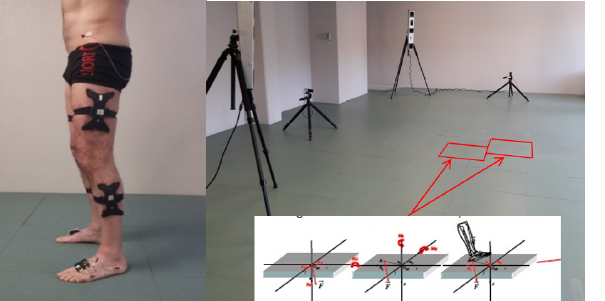
Figure 2. Clinical gait analysis. Different types of sensors are used to conduct kinematic and kinetic analyses of locomotion in gait labs. These may include optoelectronic motion capture, force platforms, electromyography, and IMU sensors, among